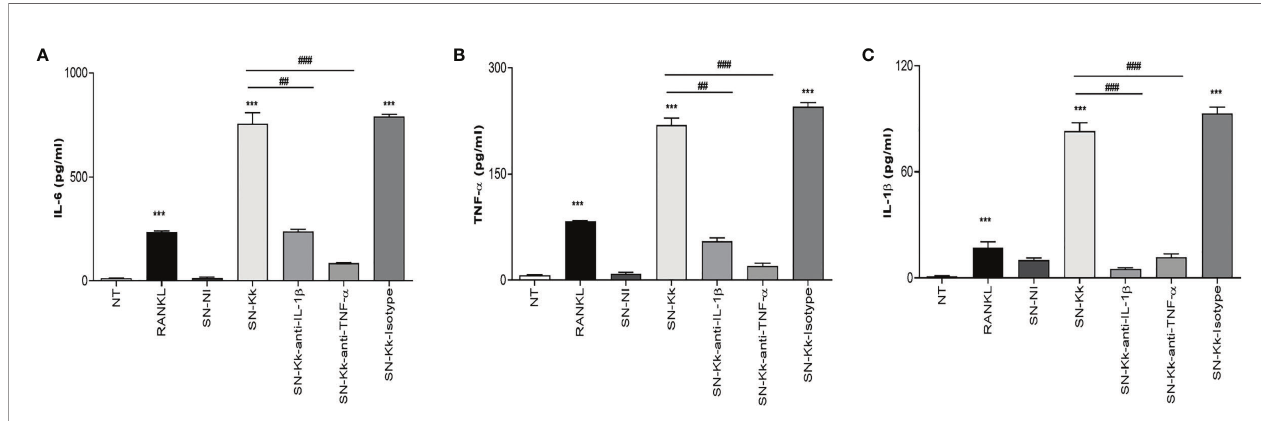
FIGURE 3 | TNF- a and IL-1 b secreted by Kingella kingae -infected monocytes determine proin fl ammatory cytokine secretion by osteoclast precursors. Culture supernatants from K. kingae -infected THP-1 monocytes at multiplicity of infection = 1 (SN-Kk), pre-incubated or not with anti-TNF- a or anti-IL-1 b -neutralizing antibody or its isotype control, were used to stimulate osteoclast precursor RAW 264.7 cells. IL-6 (A) , TNF- a (B) , and IL-1 b (C) secretion was determined in culture supernatants by ELISA. NT, non-treated. The graphics are showing values obtained from three independent experiments. Data are given as mean ± SD. *** P